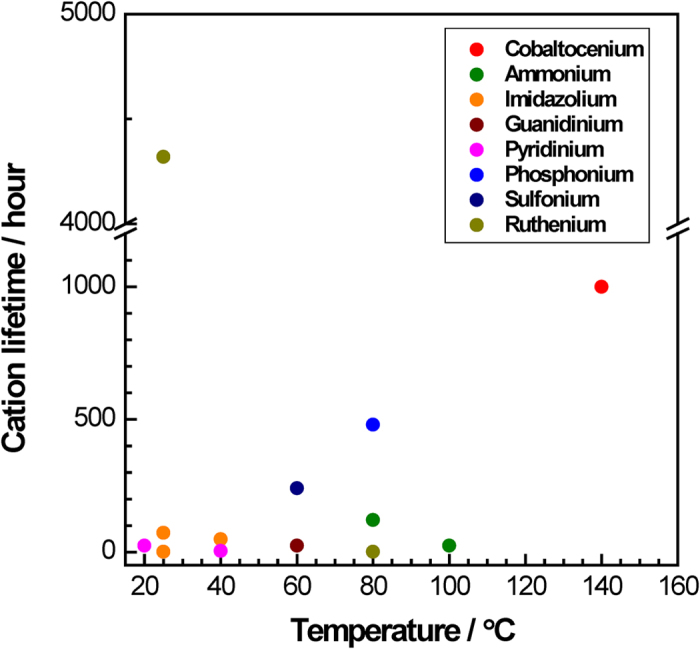
Alkaline stability of Cp*2Co+ and other reported cations.Test conditions: 1 M KOD or NaOD in D2O, 20% degradation threshold on 1H NMR basis (unless otherwise noted). Cobaltocenium: Cp*2Co+ (13C NMR spectroscopy, this work). Ammonium: benzyl-trimethylammonium (btmAm) [80 °C in 1 M NaOD/(D2O+CD3OD)8 and 100 °C in 1 M NaOD/D2O, this work]. Imidazolium: benzyl-1-methyl-limidazolium (bmIm)67, 1,3-dimethyl-2-phenyl-benzimidazolium (dmpBIm) (0.3 M KOH)6, 1,3-dimethyl-2-(2,4,6-trimethylphenyl)-benzimidazolium (dmtmpBIm) (1.3 M KOH)6. Guanidinium: benzyl-pentamethylguanidium (bpmGu) (this work). Pyridinium: benzylpyridinium (bPy) (this work). Phosphonium: tetrakis(dialkylamino)phosphonium (tkdaaPh) [1 M NaOD/(D2O+CD3OD)]8. Sulfonium: (4-methoxyphenyl)-diphenylsulfonium (mopdpSu)31. Ruthenium: bis(terpyridinine)ruthenium (ttpRu) (UV-vis spectroscopy). The chemical structures of those cations are shown in Table S3. 1H NMR spectra of btmAm, bpmGu, and bPy are not shown.